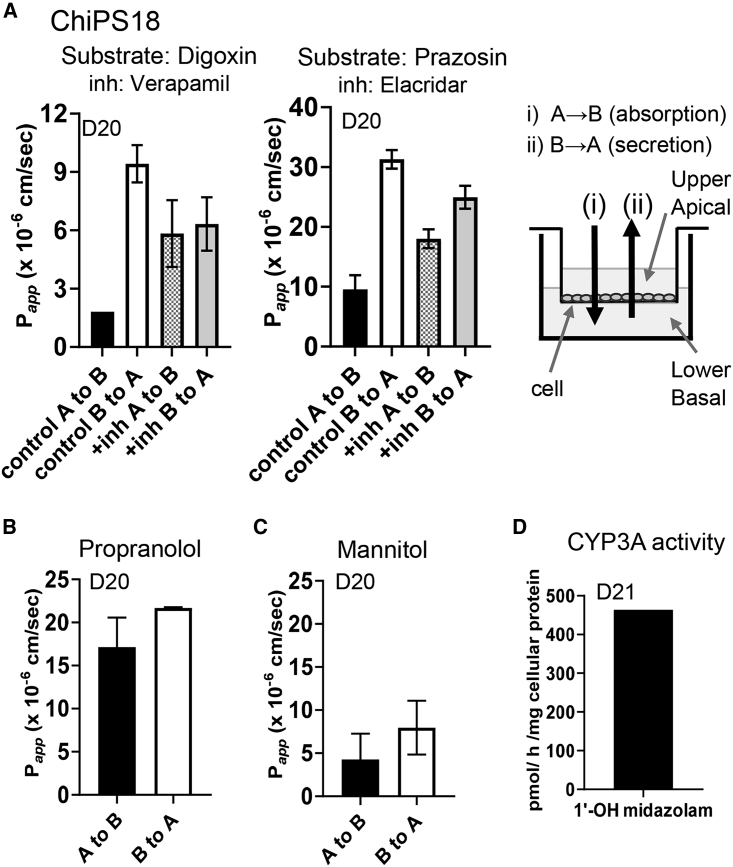
hiPSC-derived Enterocyte-Like Cells Showed the Functions of Efflux Transporters and High Permeability for Propranolol and Low Permeability of Mannitol(A) Transport activities of P-gp and BCRP were tested with their representative substrates and inhibitors. (Left) Directional transcellular transport (B-to-A and A-to-B) of digoxin (1.27 nM) (P-gp selective substrate) in the absence (control) or presence (+inh) of verapamil (P-gp inhibitor). (Middle) Directional transcellular transport (B-to-A and A-to-B) of prazosin (0.391 nM) (BCRP and P-gp substrate) in the absence (control) or presence (+inh) of elacridar (P-gp and BCRP dual inhibitor). (Right) Schematic drawing of the experiment.(B) The transport of propranolol (1.33 nM), which is mainly through the transcellular route by passive membrane permeation, was examined.(C) The transport of mannitol (1.35 nM), which is mainly through the paracellular route, was examined. (A–C) Papp values calculated from the slope of the time-dependent transcellular transport of substrates (Figure S1) are plotted. Data are expressed as the mean ± SD (n = 3; n, number of biological duplicates).(D) CYP3A4 activity was examined to check the formation of 1′-OH midazolam from 10 μM midazolam (n = 2). Additional experiment to confirm reproducibility of transport and metabolic enzyme CYP3A activities was performed and shown in Figure S2.